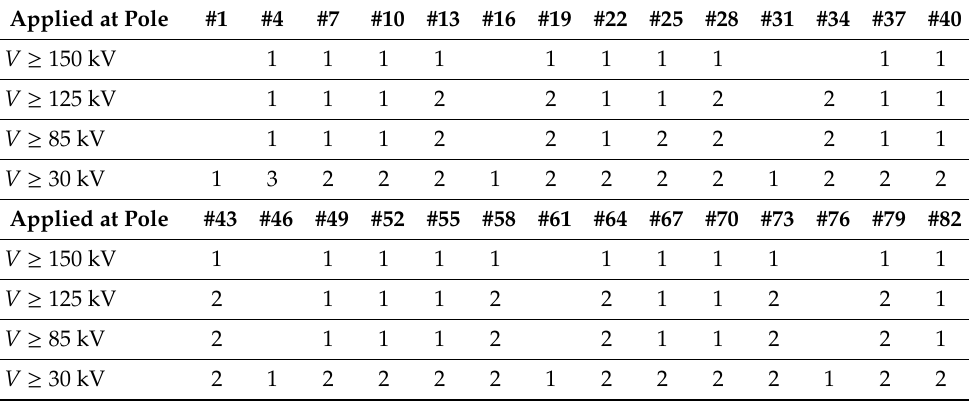
Table 9. Number of transformers with at least one phase reaching the critical overvoltage level. Case 3, wet arsenic-impregnated poles, sub-configuration